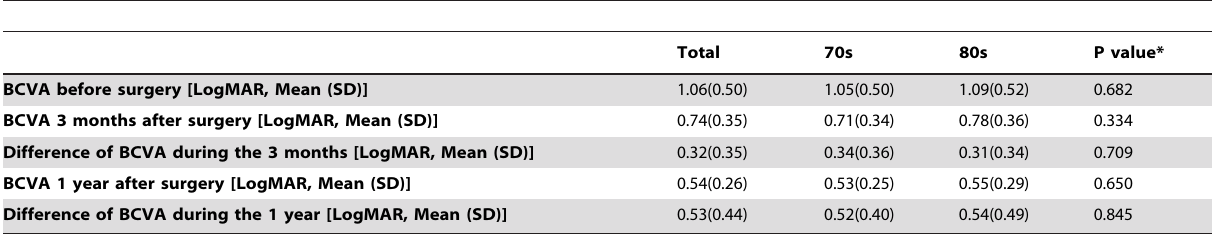
Table 2. Outcomes of visual acuity for RRD surgery in an elderly population